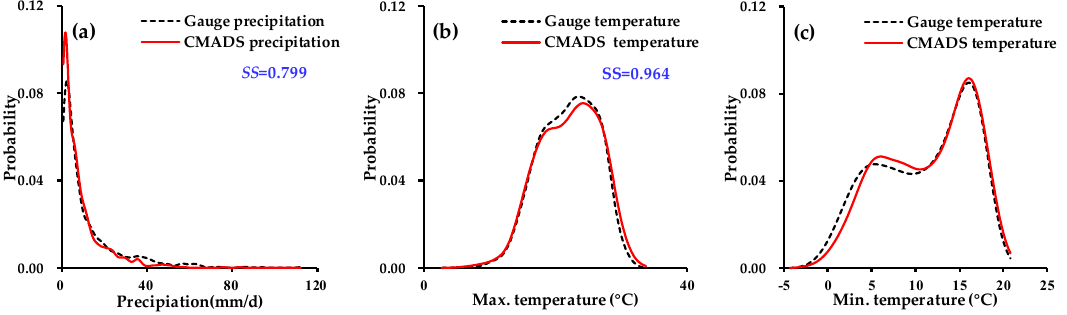
Figure 5. PDFs for the daily CMADS reanalysis data and gauge observations: ( a ) Precipitation; ( b ) Maximum temperature; ( c ) Minimum temperature.